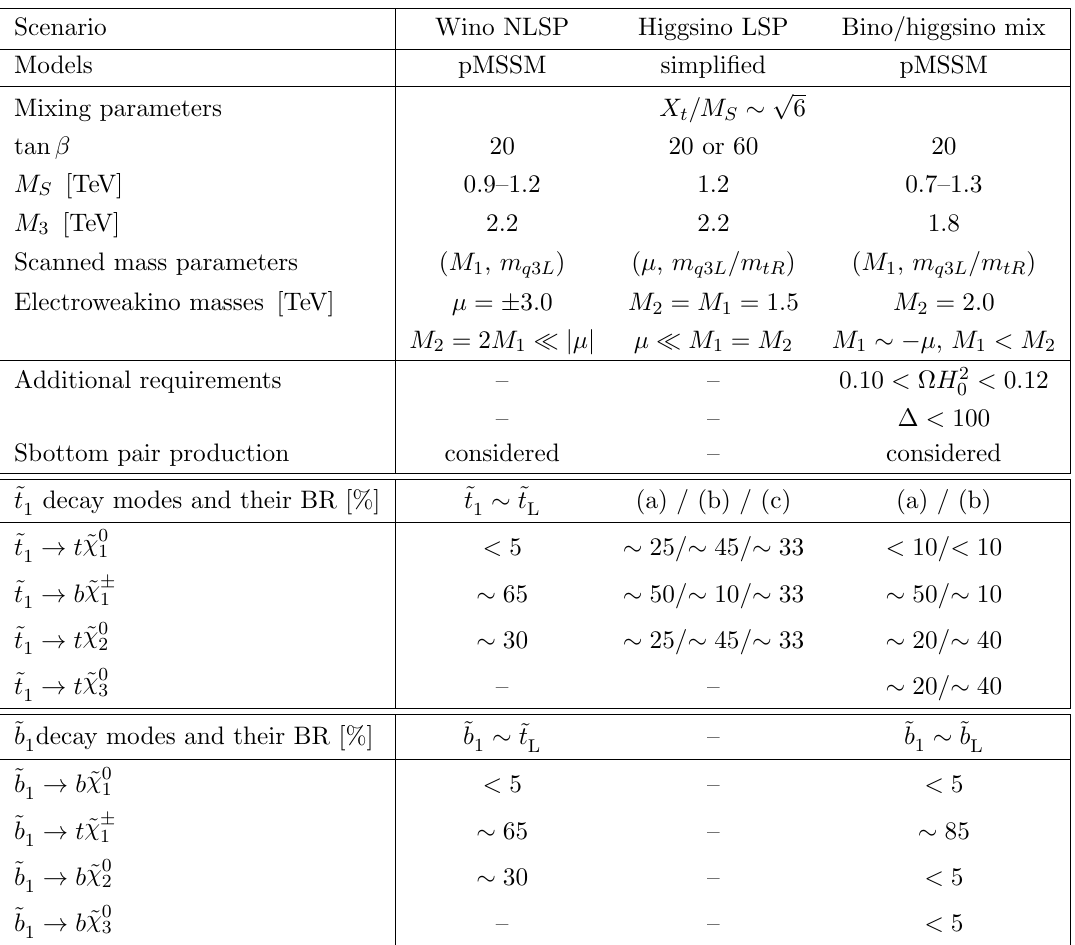
Table 2 . Overview of the input parameters and typical stop decay branching ratios (BR) for the signal models. Lists of mass parameters scanned are provided in between parentheses. The pMSSM mass parameters that are not shown below were set to values above 3 TeV. The table represents seven di(cid:11)erent models that are used in the interpretation of the results (two for the wino NLSP, three for the higgsino LSP, and two for the bino/higgsino admixture). For the higgsino LSP scenarios, a simpli(cid:12)ed model is used instead of a pMSSM model, although the stop decay BR are based on pMSSM scans with the parameters shown in the table. For the higgsino and bino/higgsino mix scenarios, the stop decay BR change depending on the ~ t for various scenarios corresponding to (a) ~ t in the higgsino model) are shown separately. For the wino NLSP model, only the ~ t is considered. Sbottom pair production is also considered where ~ b bino/higgsino mix